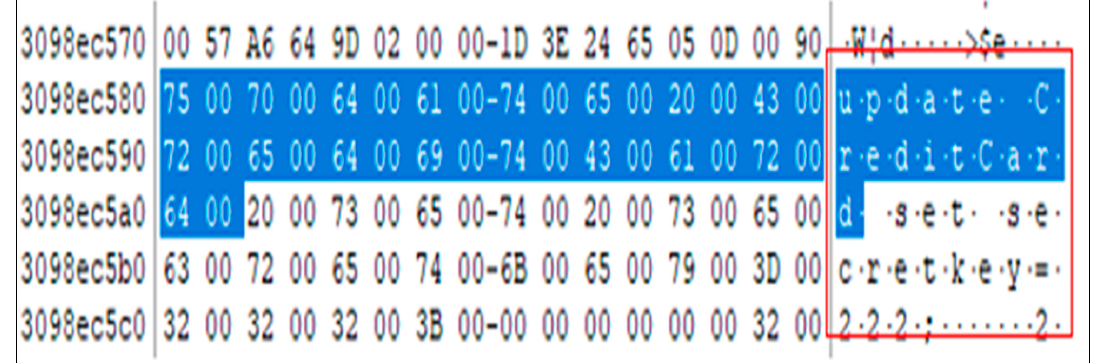
Figure 14. Results of verification.